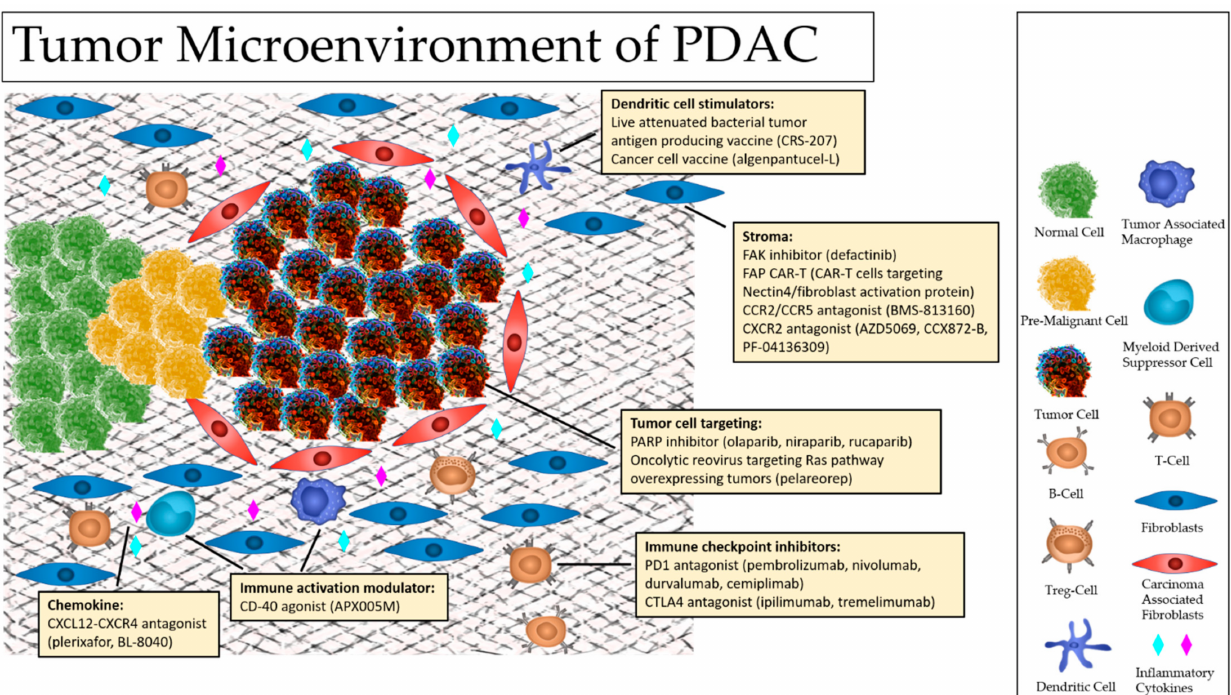
Figure 1. Pancreatic Ductal Adenocarcinoma (PDAC) Tumor